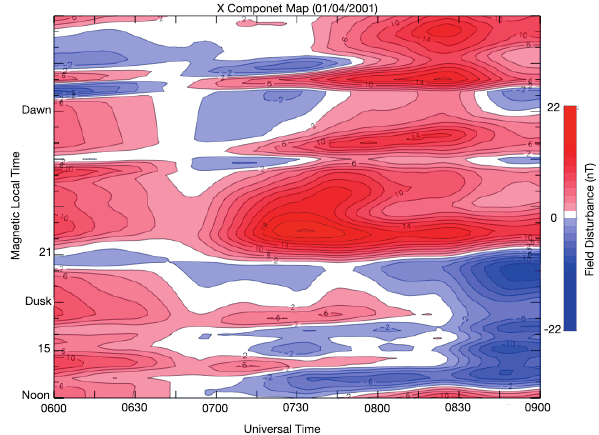
Fig. 2. An MLT-UT map of mid-latitude magnetic perturbations for the isolated substorm on 4 January